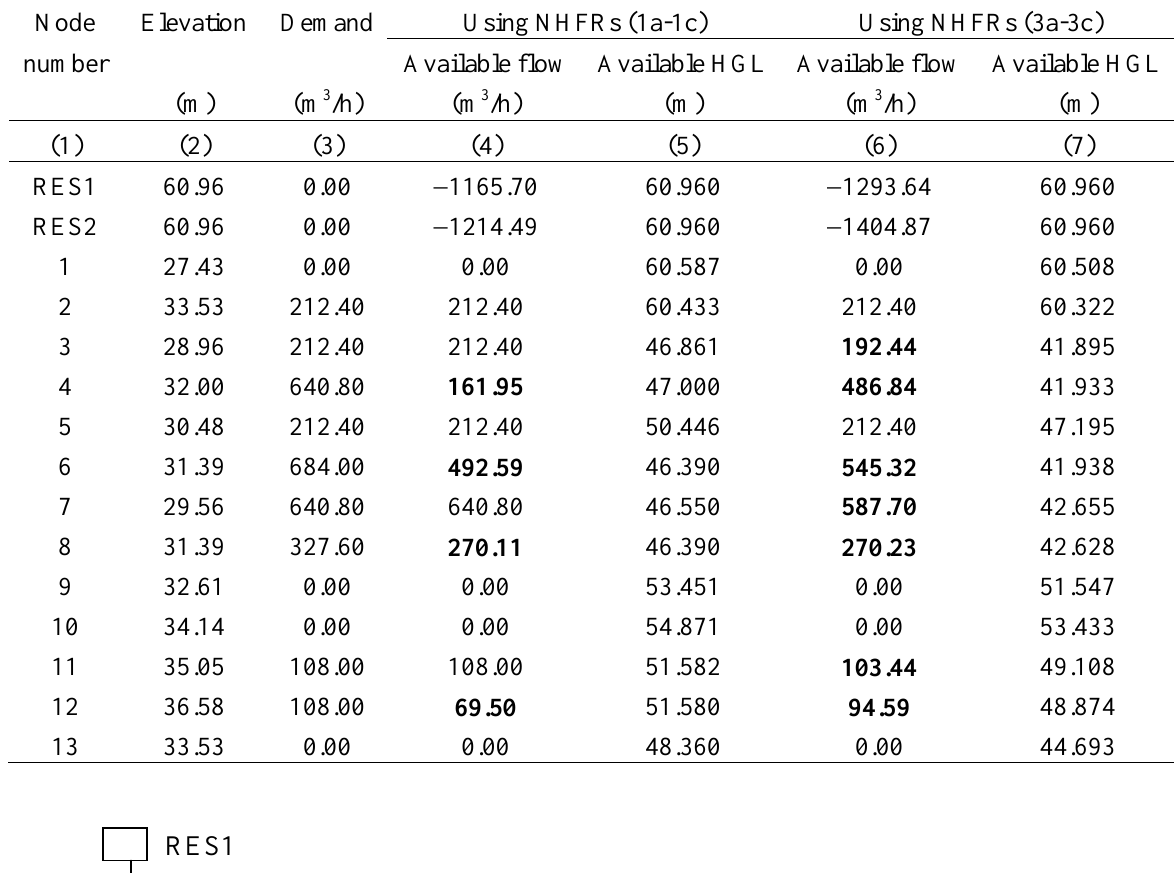
Table 4. Node data and NFA results for failure of Pipe 3.